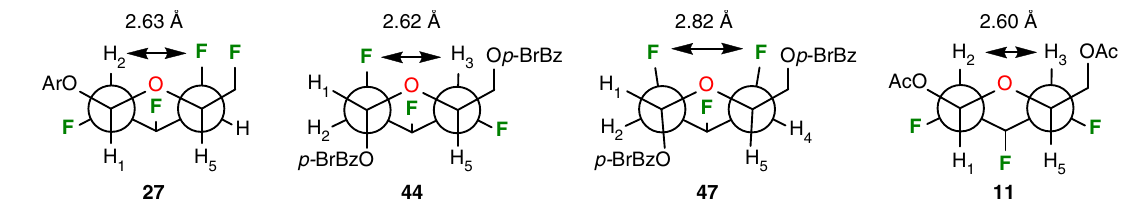
Fig. 8 Newman projection of fl uorinated pyrans. Talopyranose derivative 47 owns 1,3-diaxial repulsion between C − F bonds